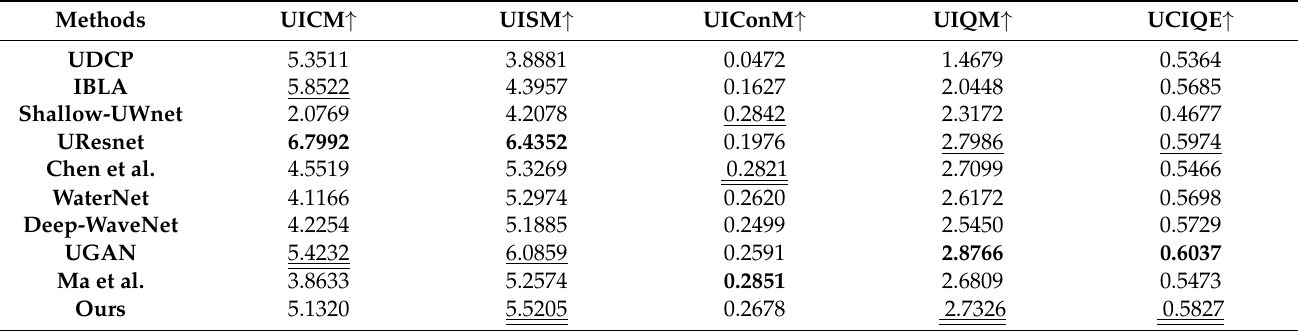
Table 3. Quantitative comparison results of various UIE approaches on the Test-C60 dataset. We present the best, second-best, and third-best results with values in bold, underlined, and double Table 2. Quantitative comparison results of various UIE approaches on the Test-90 dataset in terms underlined, of PSNR (dB), SSIM, and MSE ( × 3 10 ). We present the optimal and sub-optimal results with values in bold and underlined, respectively.